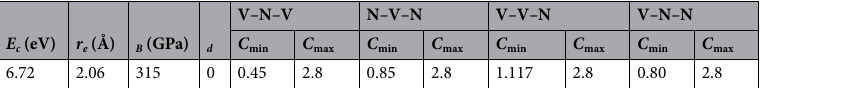
Table 2. A set of 2NN MEAM potential parameters for V-N system. E c , r e , B , d , and C represent cohesive energy, equilibrium distance, bulk modulus, adjustable parameter and screening parameter of B1 phase